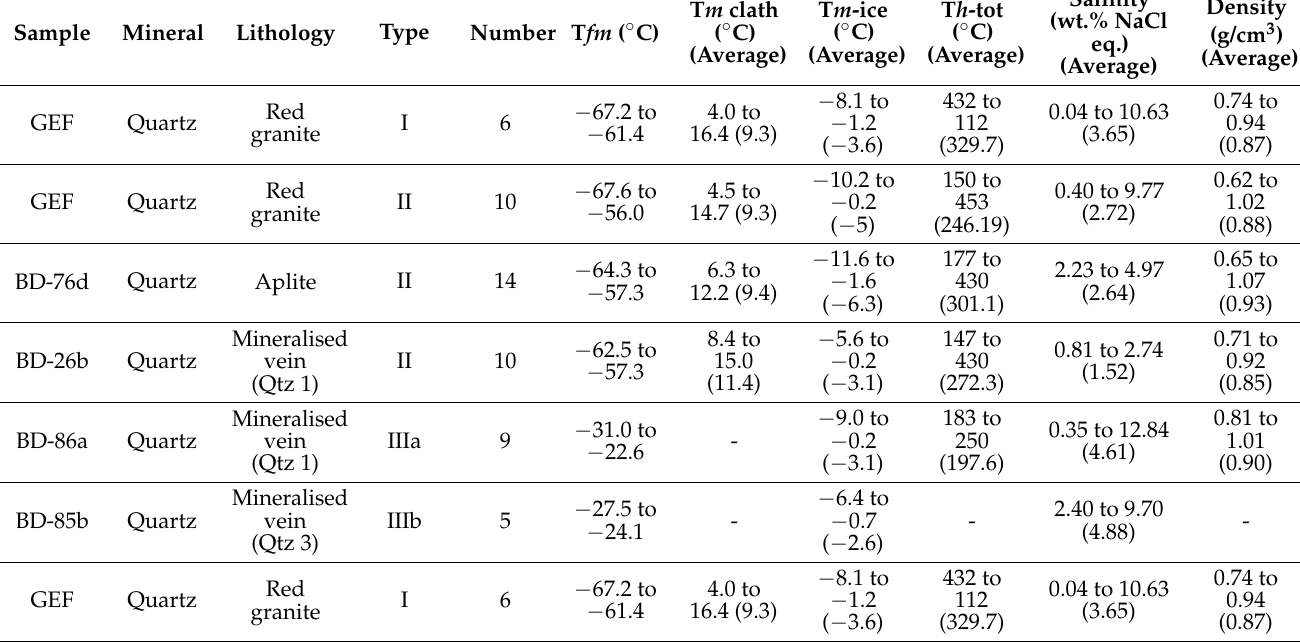
Table 1. Microthermometric results of fluid inclusions in quartz from the Passa Tr ê s gold deposit. Abbreviations: Qtz—quartz; T fm —first melting temperature; T m -clath—CO 2 clathrate melting